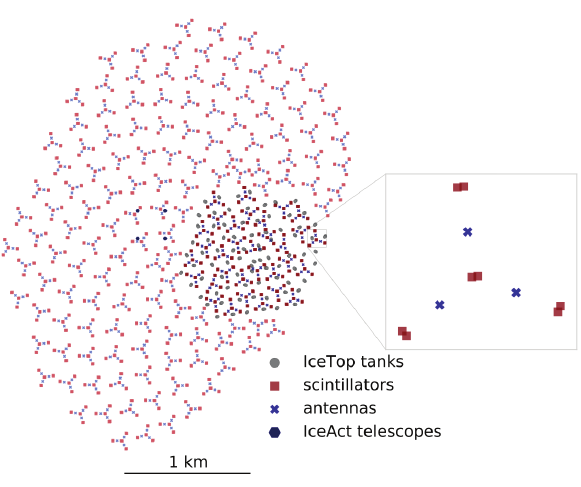
Figure 15: Layout of the currently under construction Ice- Top surface enhancement array (darker colors) and the proposed surface component of the future IceCube-Gen2. Modified from